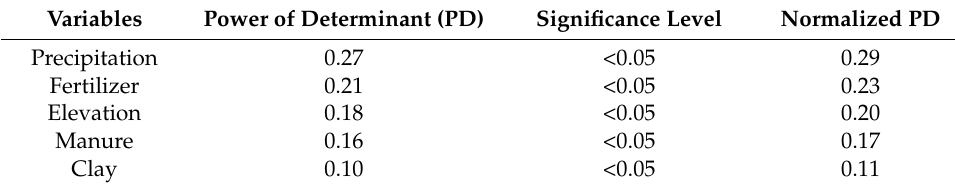
Table 5. PD values and normalized PD values of significant predictor